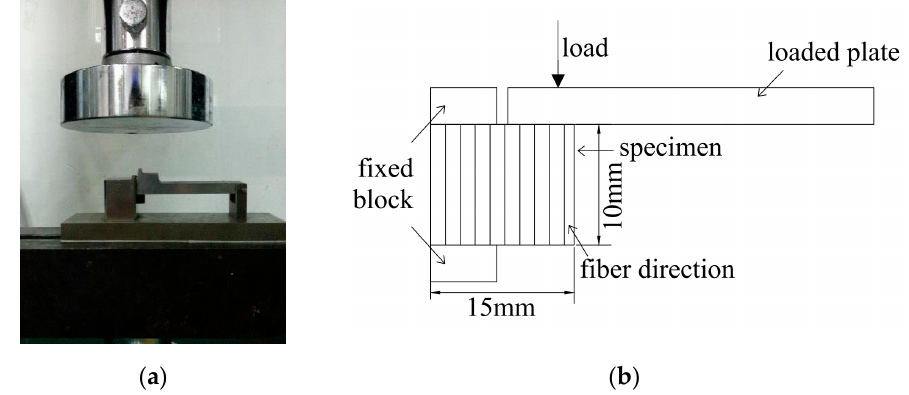
Figure 4. In-plane shear test: ( a ) Realistic diagram; ( b ) Schematic diagram.